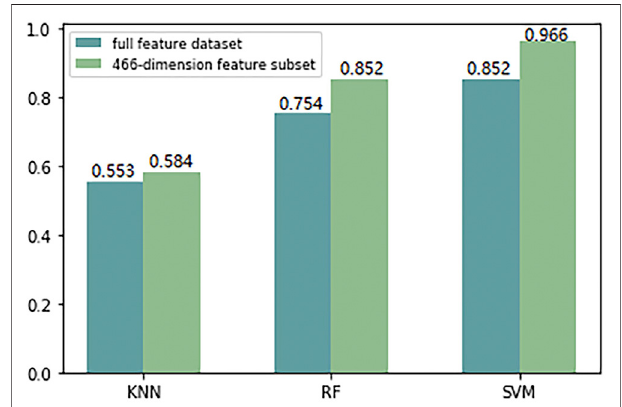
FIGURE 3 | Comparison the ACC values of the full feature set and 466- dimensional feature subset extracted by monoDiKGap(k (cid:1) 2) under different classi fi